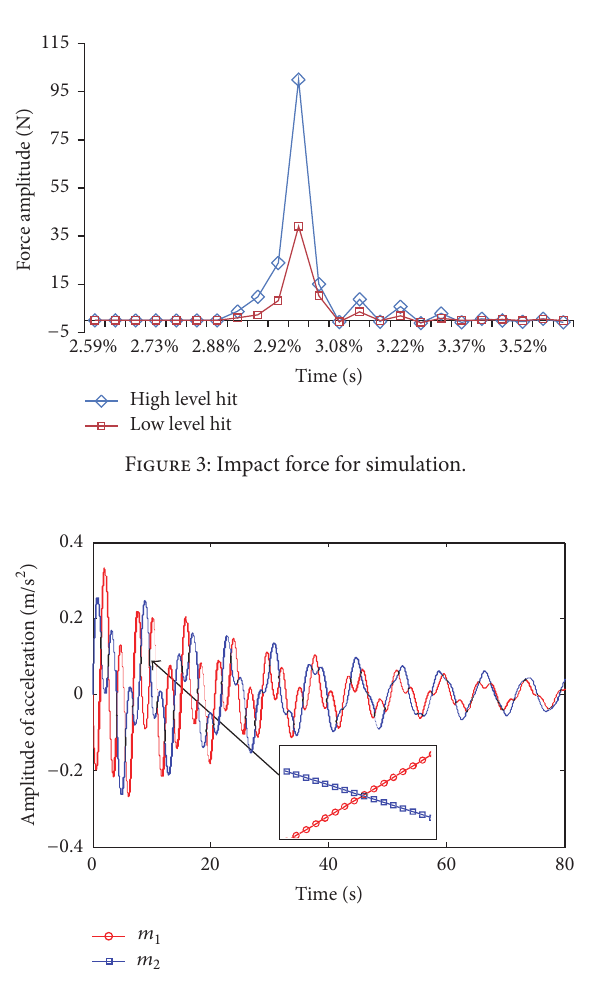
Figure 4: Mass acceleration time histories.